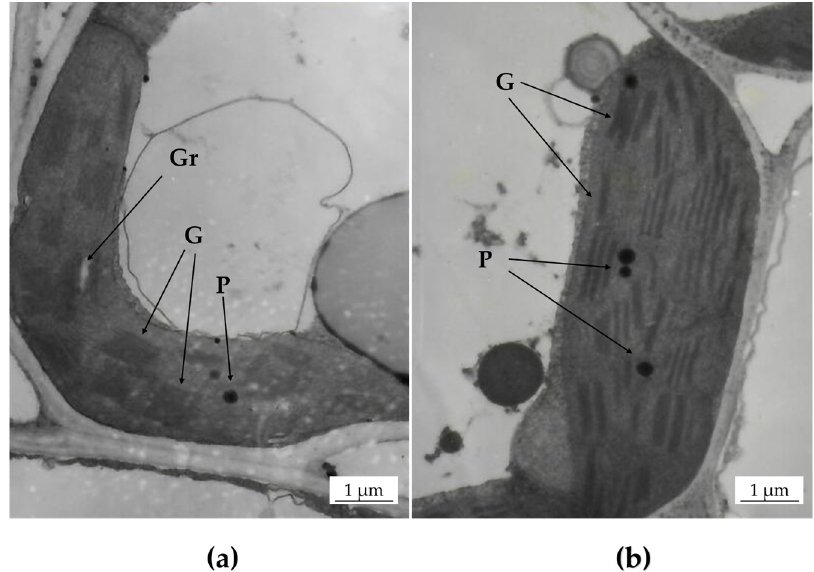
Figure 2. Chloroplast ultrastructure of wild-type ( wt ) and chlorophyll b -deficient ( ch11 ) rice. ( a ) Normal chloroplast structure of wt rice; ( b ) Abnormal chloroplast structure of ch11 rice, showing indistinct thylakoid membranes, an absence of granules, and numerous plastoglobuli. G, grana; P, plastoglobuli; Gr, granules.